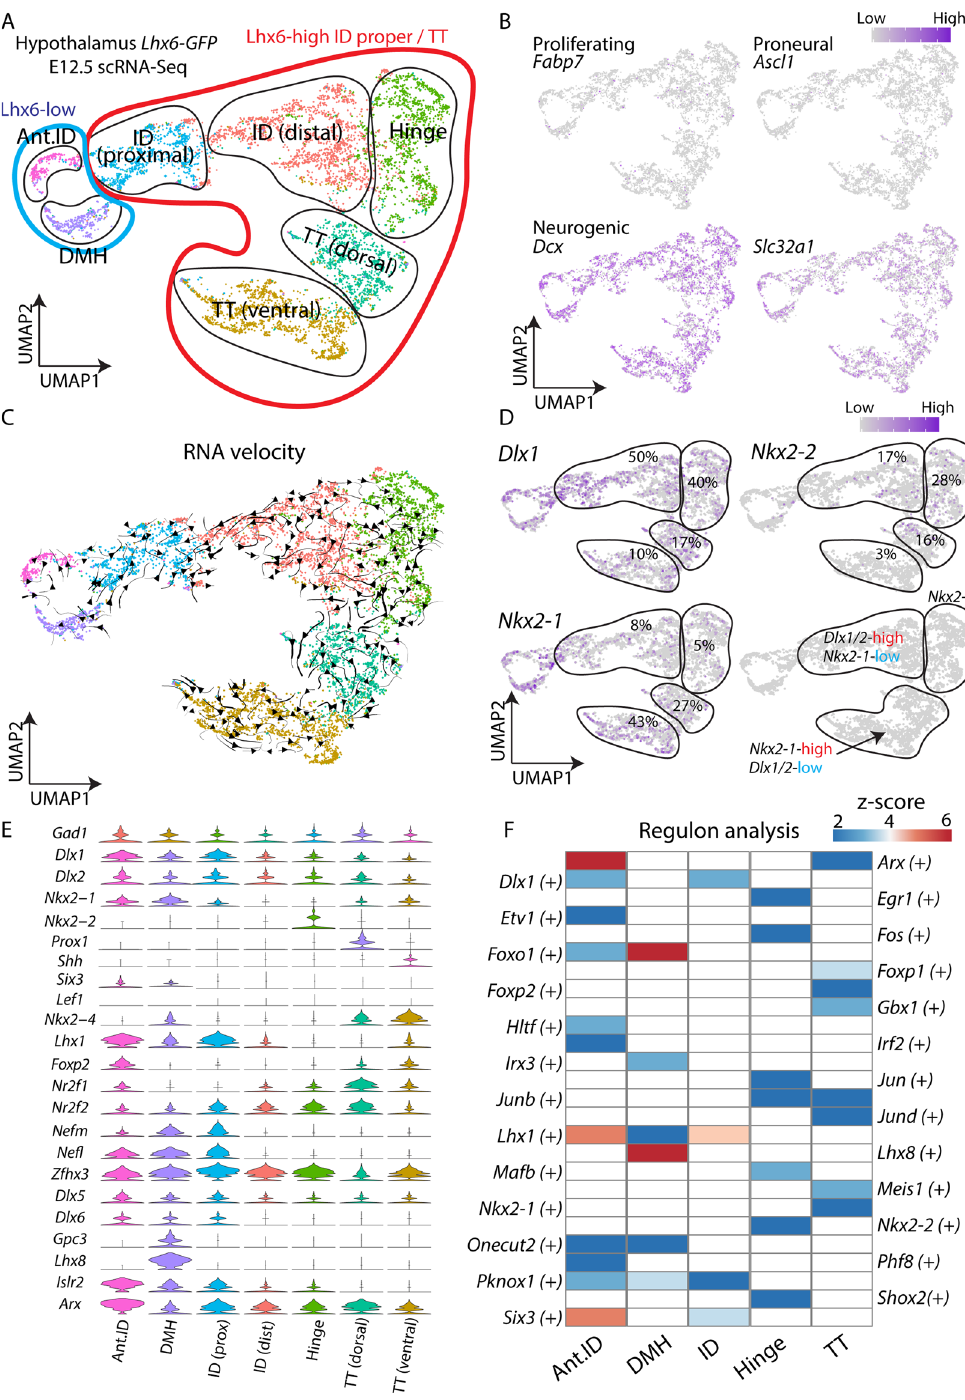
Fig. 4 scRNA-Seq identi fi es molecular markers of spatially distinct domains of hypothalamic Lhx6 neurons. A UMAP plot showing different Lhx6- expressing hypothalamic regions at E12.5. B UMAP plots showing a lack of expression of Fabp7 (proliferating cells), Ascl1 (proneural), whereas the neuronal precursor marker Dcx and the GABAergic neuronal marker Slc32a1 is highly expressed. C UMAP plot with RNA velocity trajectories. D UMAP plots showing expression and percentage of ID, hinge, and TT Lhx6 neurons expressing Dlx1/2 , Nkx2-2 , and Nkx2-1 . E Violin plots showing expression of key transcription factors (and other genes) that are highly expressed in individual domains. F A heatmap showing z -scores of signi fi cantly differentially expressed key regulatory transcription factors among Lhx6 + hypothalamic regions. Note activity of Dlx1 in the ID, Nkx2-2 in the hinge, and Nkx2-1 in the TT. Ant.ID anterior ID, DMH dorsomedial